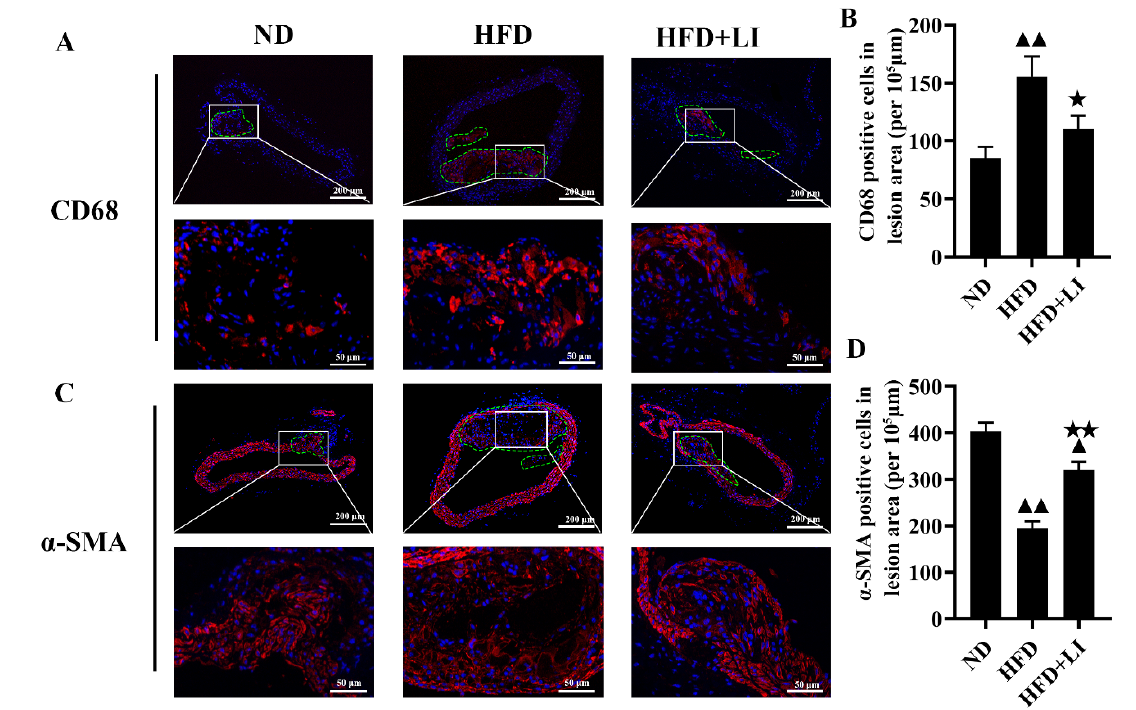
Figure 2. Effects of low dietary iron on ApoE KO mice aortic macrophages and smooth muscle cells. ( A ) Representative immunofluorescent staining images of macrophages in a murine atherosclerotic plaque. Nuclei were stained with DAPI (blue), and CD68-positive macrophages were revealed by Alexa Fluor 594 (red). ( B ) Quantification of ( A ) (% positive area). ( C ) Representative immunofluorescent staining images of smooth muscle cells in murine atherosclerotic plaque. Nuclei were stained with DAPI (blue), and α SMA-positive smooth muscle cells were revealed by Alexa Fluor 594 (red). ( D : Quantification of ( C ) (percentage positive area). Scale bar = 50 μ m. ▲▲ p < 0.01 vs. ND; ★ p < 0.05 vs. HFD; ★★ p < 0.01 vs. HFD. ND: normal diet-fed ApoE KO mice, HFD: high fat diet-fed ApoE KO mice, HFD + LI: high fat diet without iron supplementation-fed ApoE KO mice.